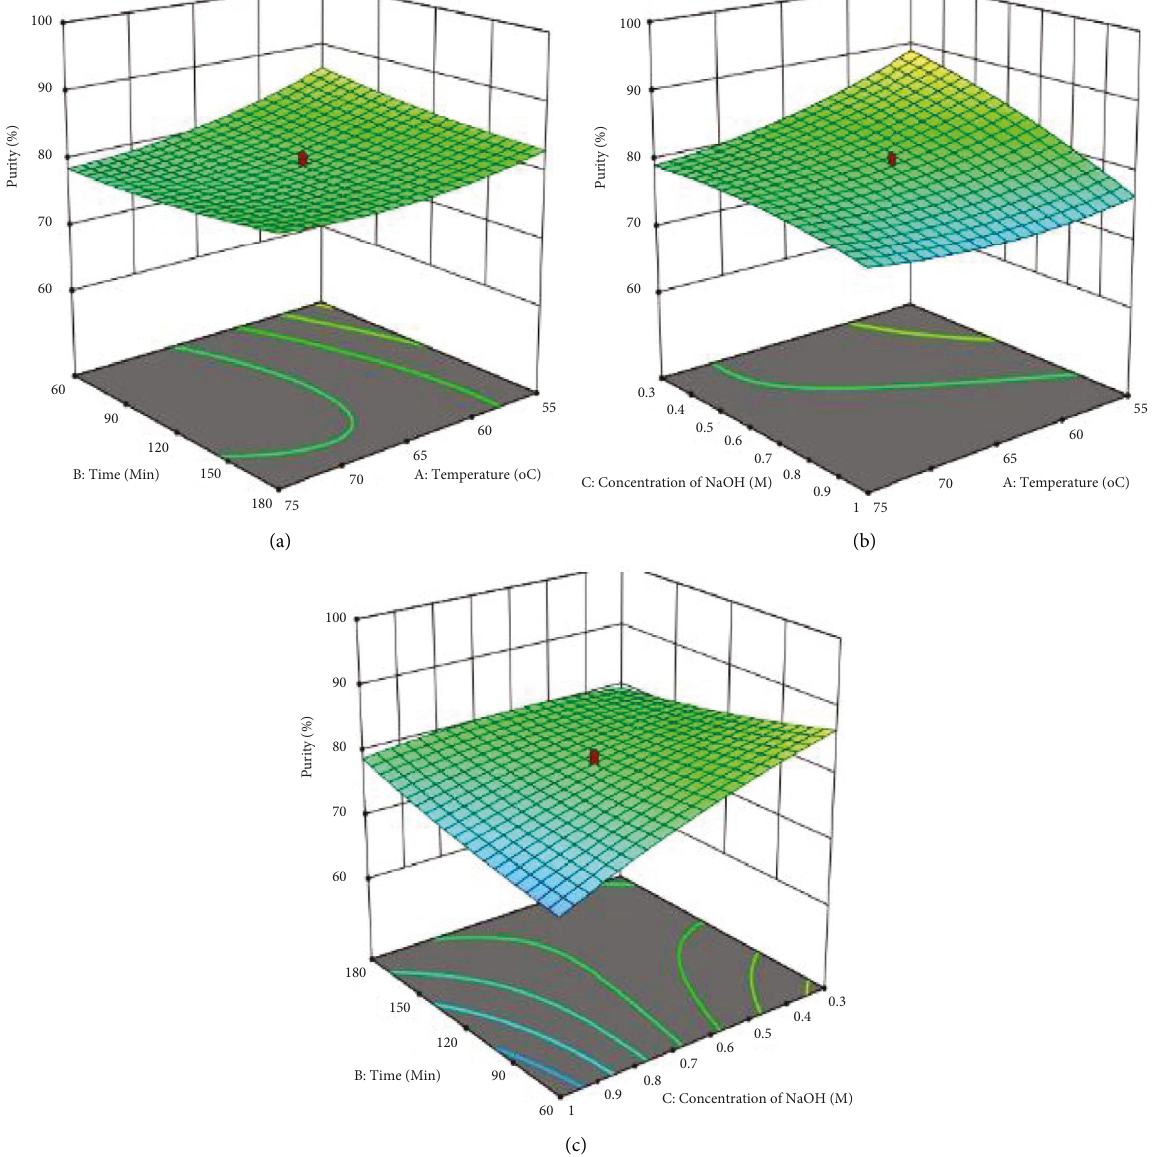
Figure 8: 3-D plot for purity percentage showing the interaction effect of (a) temperature and time, (b) temperature and concentration, and (c) time and